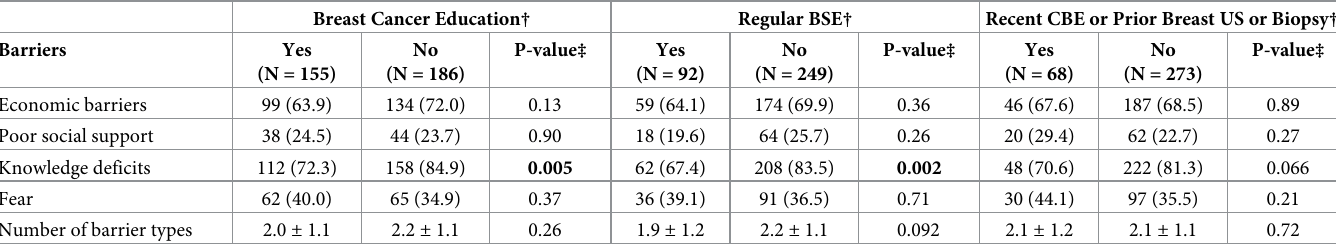
Table 3. Associations between patient-related barriers and participation in breast cancer detection